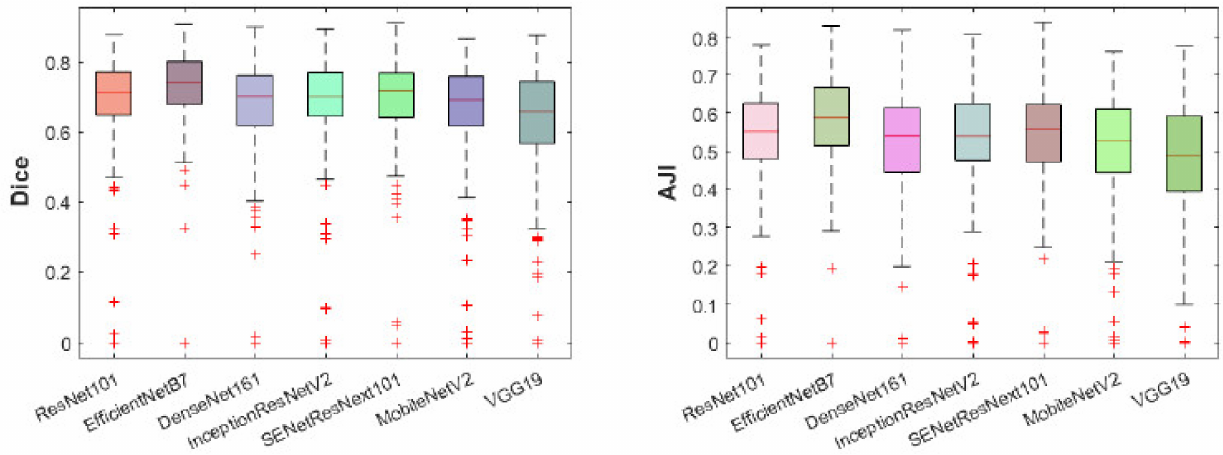
Figure 6. The box plots of Dice ( left ) and AJI ( right ) scores for all the test data sets. Different boxes with colours represent the different backbones of the U-Net model. The median value of every box is the red line inside the box; the outliers are labelled as the red (+) symbol.